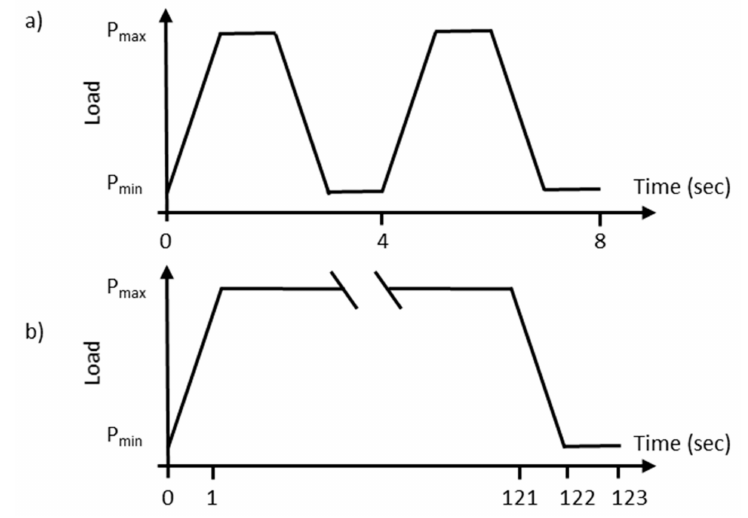
Figure 5. ( a ) Low-cycle fatigue (LCF) waveform, ( b ) Dwell